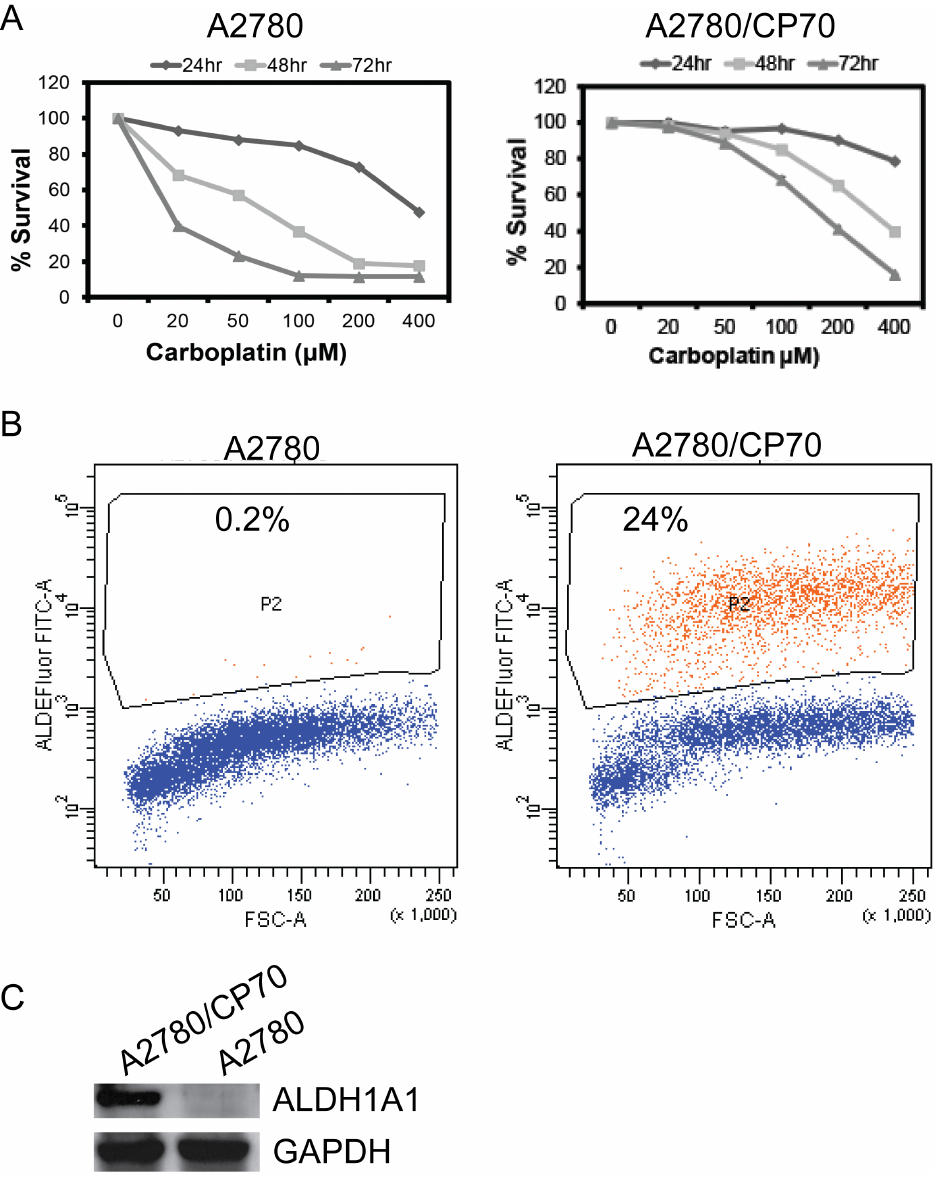
Figure 1. ALDH1A1 status correlates with platinum resistance in ovarian cancer cells. Isogenic cell lines (A2780- platinum sensitive & A2780/CP70- platinum resistant) were evaluated for platinum response using drug sensitivity assay as described in M&M section (A). To assess the percent of ALDH + cells, in A2780 and A2780/CP70 cells ALDEFLUOR assay was performed by using BODIPY-aminoacetaldehyde (BAAA) as substrate for ALDH enzyme, after 40 minutes incubation at 37 u C flow cytometry analysis was performed (B) and western blot data shows representing levels of ALDH1A1 isozyme in these cells (C).